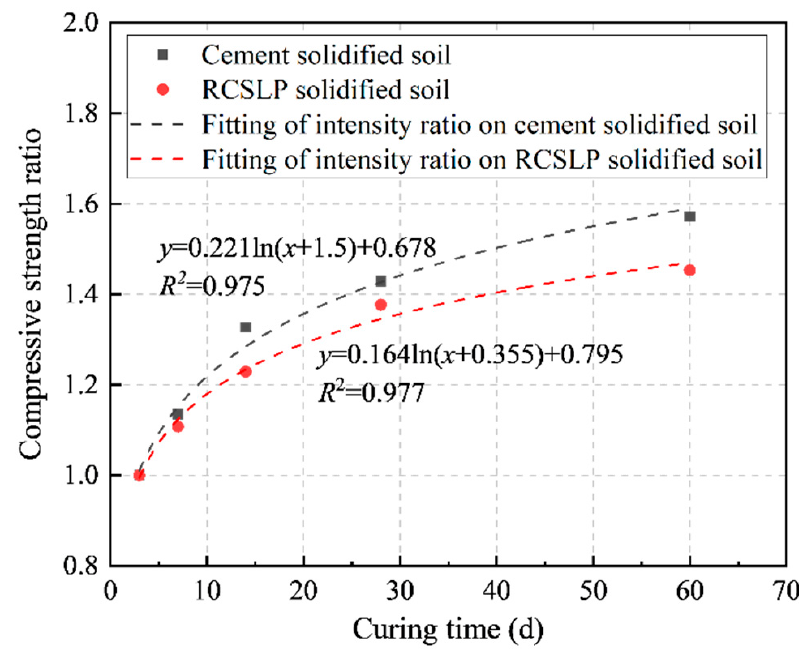
Figure 10. Compressive strength ratio variation of the solidified soil with curing time.